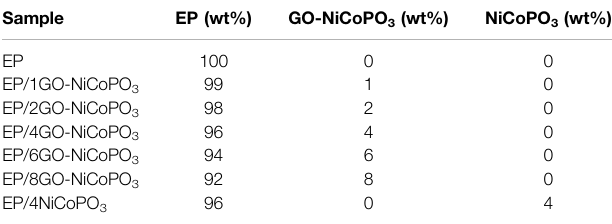
TABLE 1 | Ingredients of EP nanocomposites.